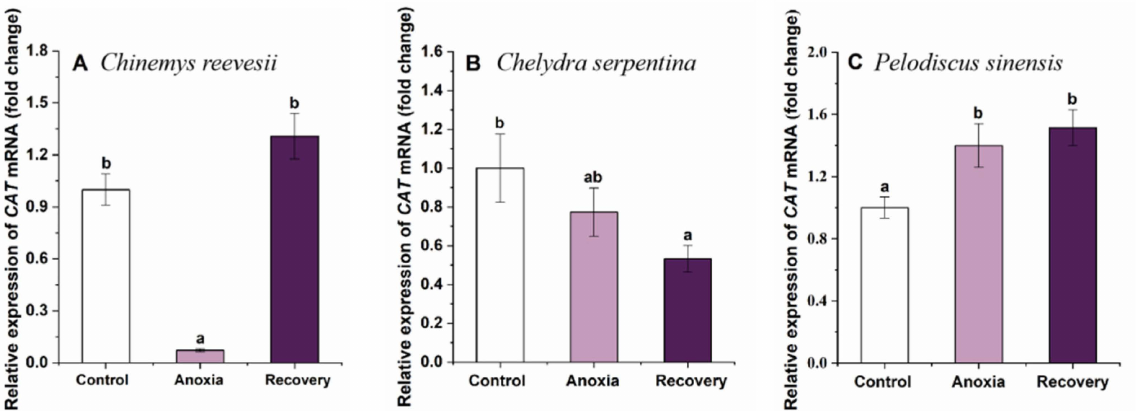
Figure 5. Changes of anoxia stress on related expression of CAT mRNA in the brain of C. reevesii ( A ), C. serpentina ( B ) and P. sinensis ( C ). Data are presented as mean ± SE. N = 8. Data with no common lowercase letters on the bar indicate significant differences between different groups ( p <